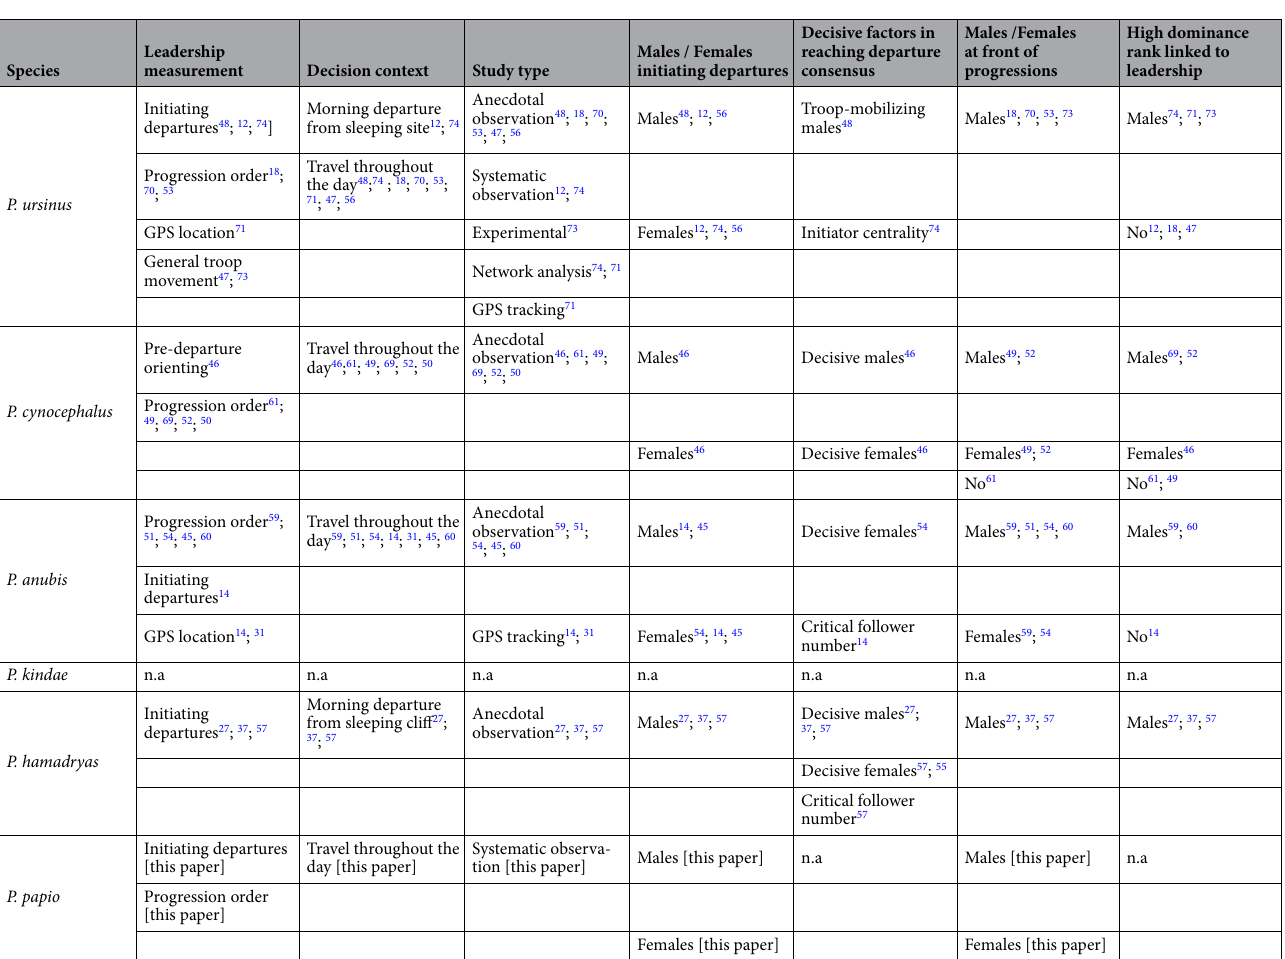
Table 1. Features of leadership during collective movement in the genus Papio . n.a. information not